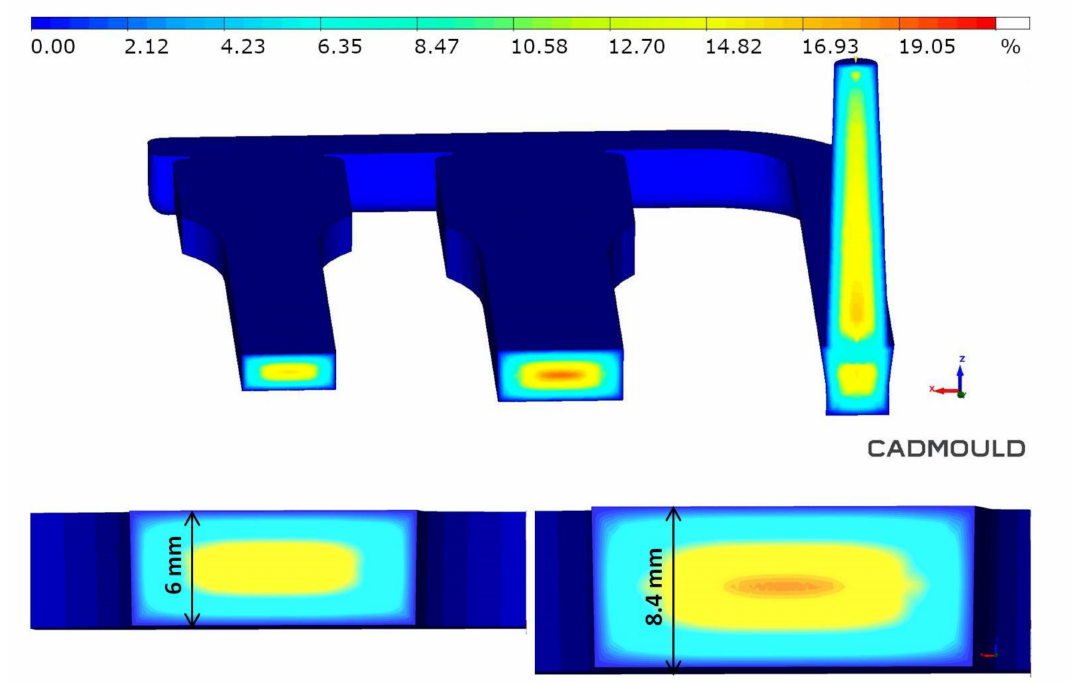
Figure 26. Gas volume distribution in the measuring cross-section of 6 mm and 8.4 mm thick polyamide samples.